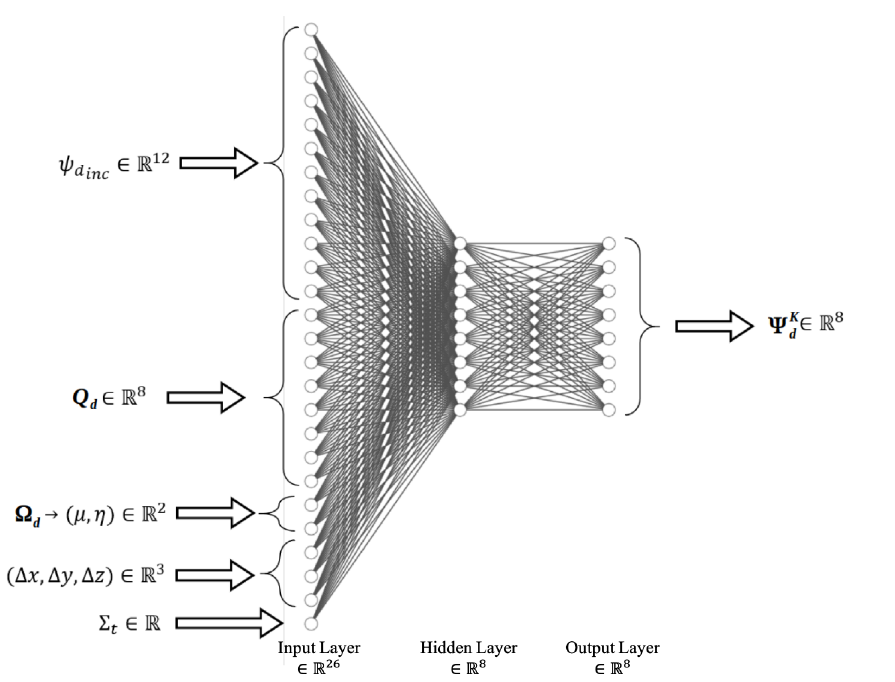
Figure 2: Concept of feed-forward ANN used in the present